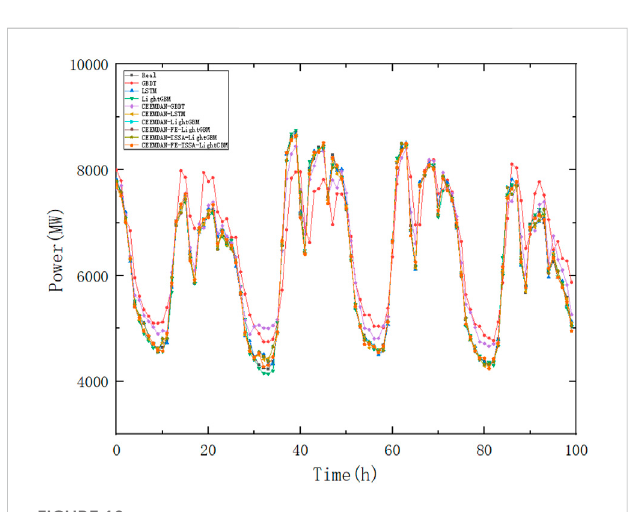
FIGURE 10 Case 1 graph of this paper ’ s model versus a single